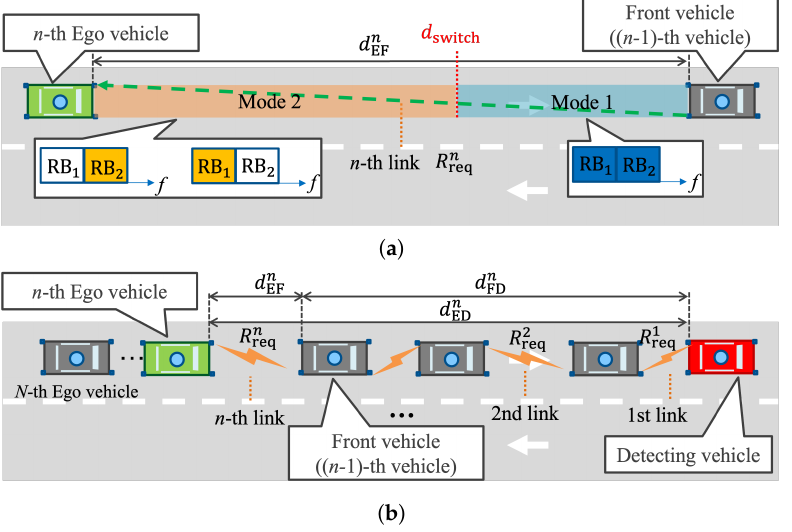
Figure 6. The schematic diagram of mmWave V2V with relays. ( a ) Regions corresponding to two transmission modes. ( b ) The mmWave V2V